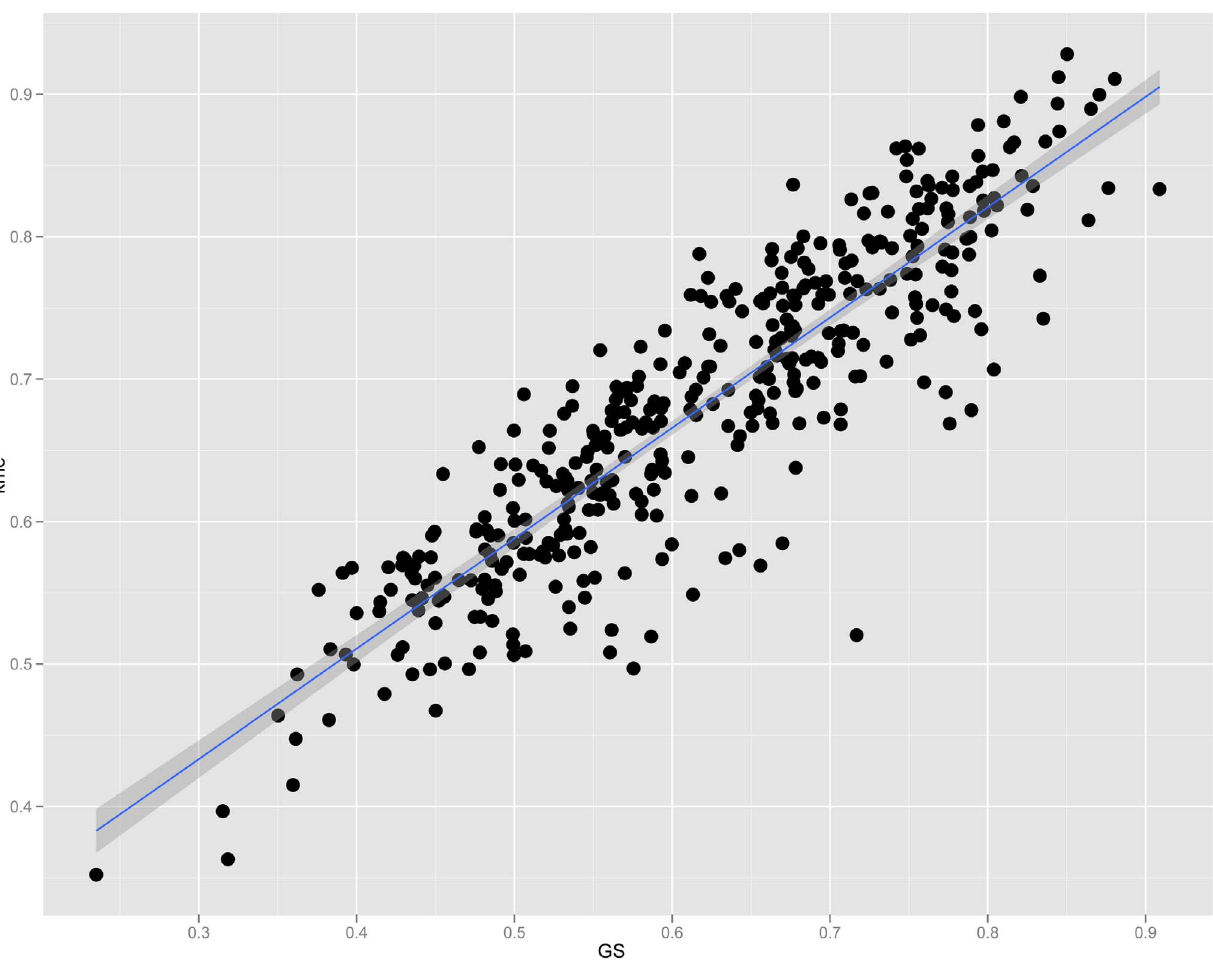
Figure 2. Connectivity is strongly correlated with GS in module 9. Plot showing the correlation (r=0.89, P=7.7 6 10 2 141 ) between connectivity (kme) and GS among module 9 genes.